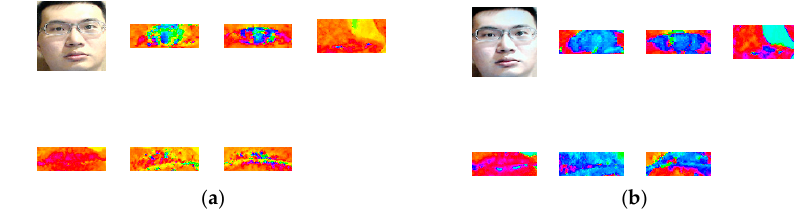
Figure 8. Hue, Saturation and Value (HSV) images of the authentic image and the spoofed image. The eyes, nose, mouse, and eyebrows feature images in HSV space. ( a ) The original (authentic) face; ( b ) The reproduced (spoofed) face.